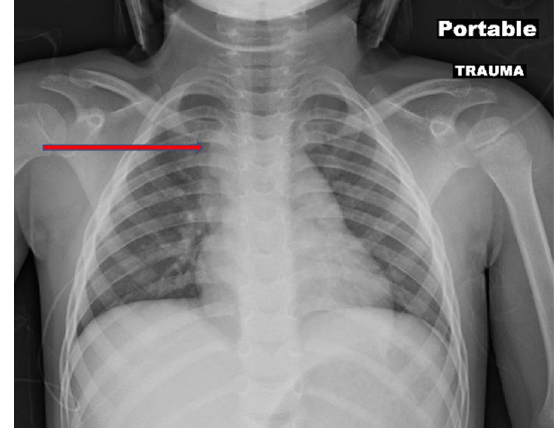
Fig. 2 Error in radiology diagnosis: right sided aortic arch misdiagnosed as normal chest